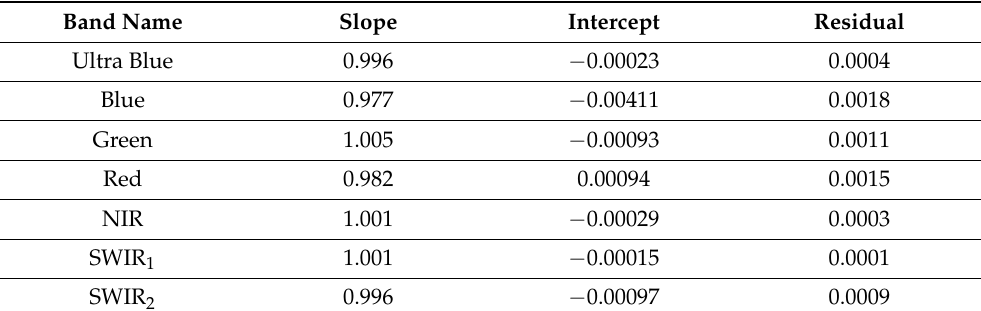
Table 5. Bandpass adjustment coefficients of linear regression for surface reflectance (OLI = slope × MSI + intercept) and the mean residual